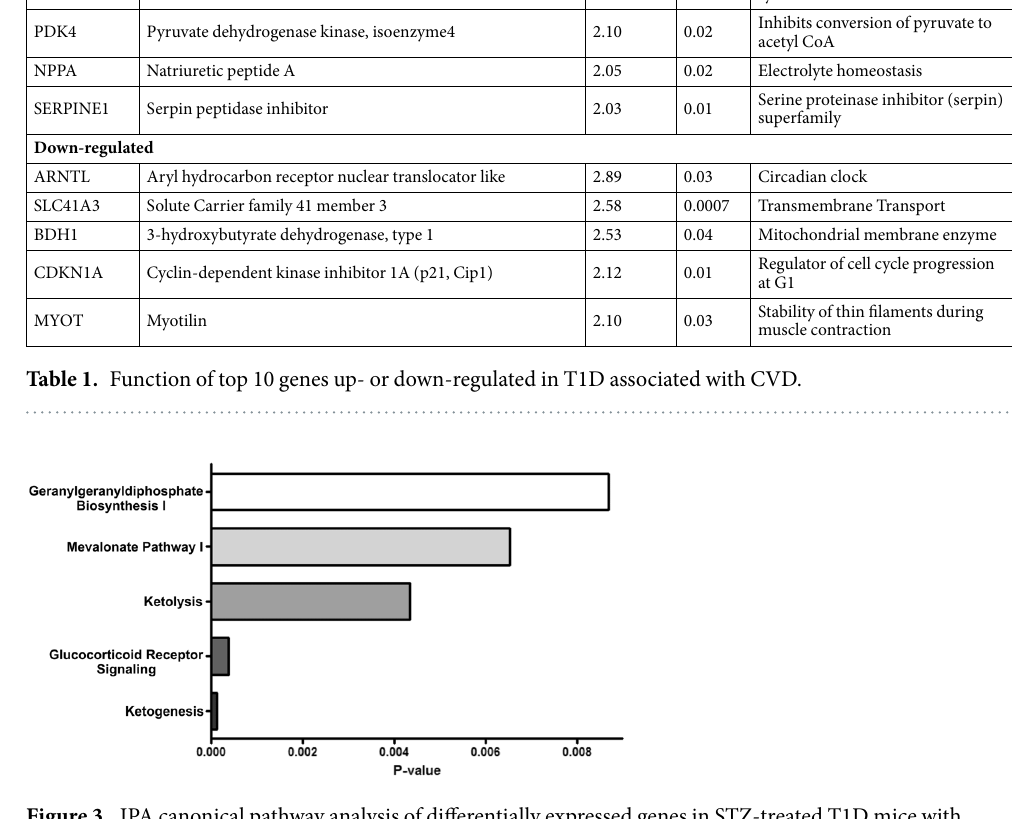
Figure 3. IPA canonical pathway analysis of differentially expressed genes in STZ-treated T1D mice with cardiac dysfunction. The bar diagram represents the top 5 over-represented canonical pathways in T1D associated with CVD. Category names are presented on the y-axis. The x-axis indicates the p value of the over- representation analysis. The inclusion of pathways is based on the presence of any 10 differentially regulated genes in